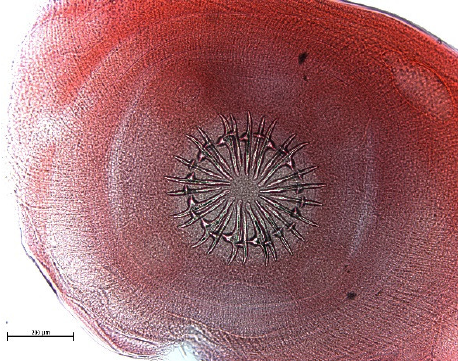
Figure 10. Larval stages of Taenia martis removed from abdominal cavity of a muskrat.